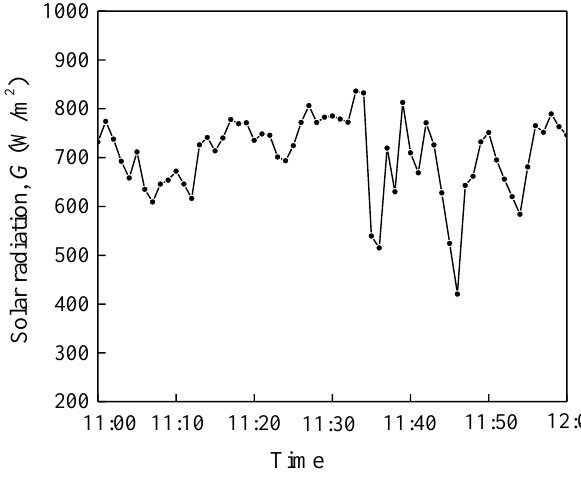
Figure 11. Variation of solar radiation with time during the experiment.